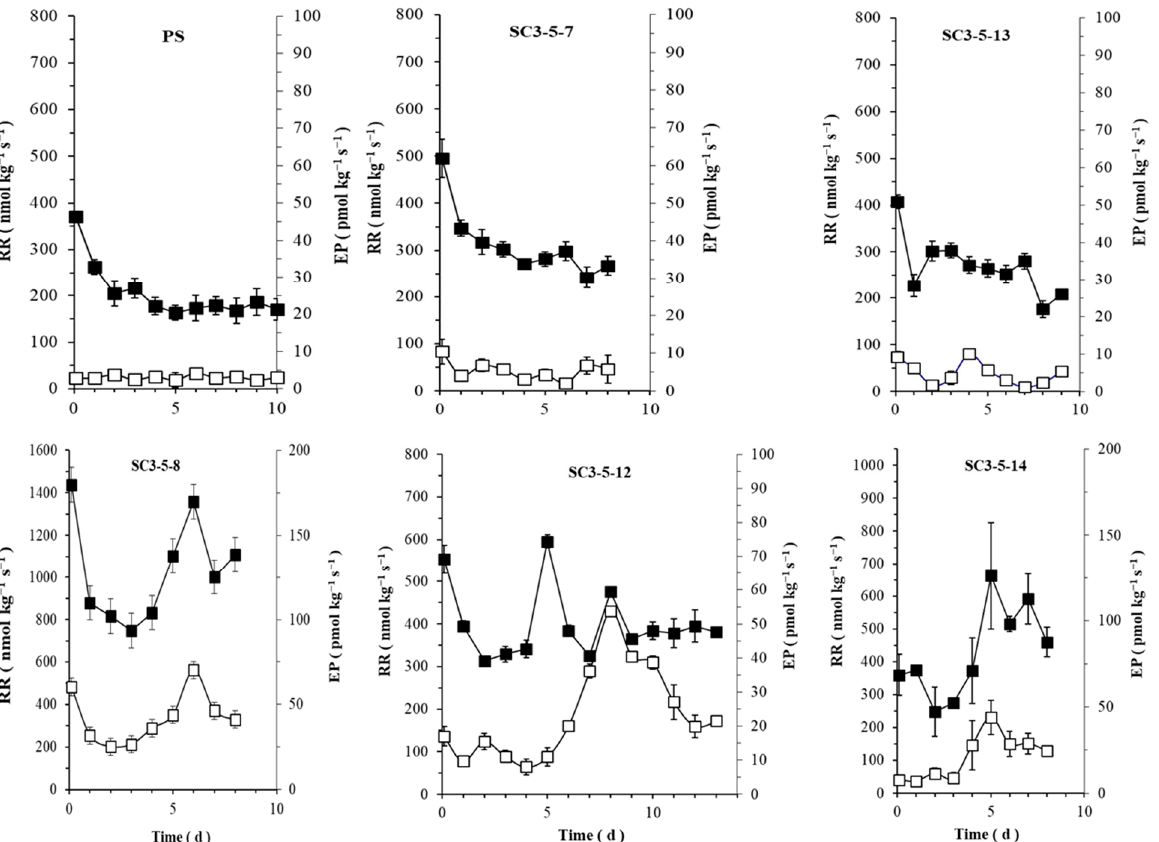
Figure 3. Respiration rate (CO 2 , ■ ) and ethylene production (C 2 H 4 , □ ) (RR and EP, respectively; mean ± S.E.) during postharvest ripening at 21 °C and relative humidity of 66 ± 6%. Non-climacteric fruits of parental PS ( n = 21) and NIL SC3-5-7 ( n = 5). Light–moderate climacteric fruits of NILs SC3-5-8, SC3-5-12 ( n = 7), SC3-5-13 ( n = 9), and SC3-5-14 ( n = 9).